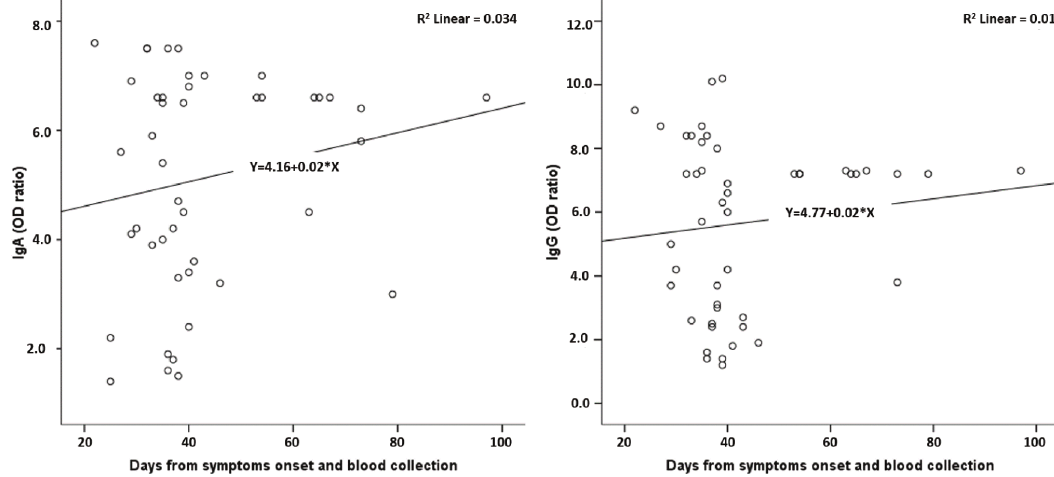
Figure 1 - Correlation of IgA and IgG OD ratio with days from symptoms onset to blood collection.